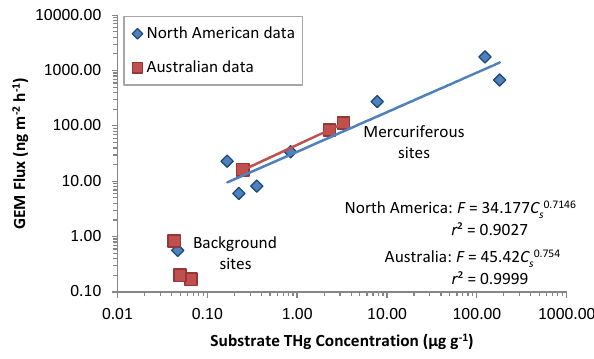
oo l s Fig. 6. Mean GEM flux and substrate THg data taken over Aus- nd T tralian and North American mercuriferous and background sites. Linear least squares lines are fitted to mercuriferous sites only, with F = GEM flux and C s = substrate THg